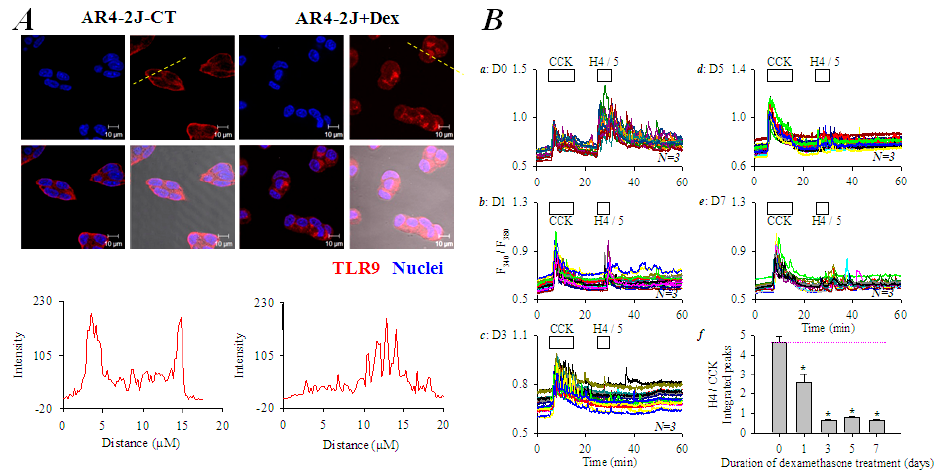
Figure 6. TLR9 migrates from the peripheral plasma membrane to cell interiors after Dex treatment, with concurrent disappearance of histone-induced calcium oscillations in AR4-2J cell clusters. ( A ) TLR9 migration from peripheral plasma membrane to cell interiors after Dex. AR4-2J cells were grown in normal medium (AR4-2J-CT) or in medium containing Dex 10 nM (AR4-2J + Dex) for 5 days before immunocytochemistry. Anti-TLR9 primary and TRITC-conjugated secondary antibodies were used (red). The nucleus was counter-stained with Hoechst 33342 (blue). Confocal images were taken (Zeiss 700) with λ ex : TRITC/555 nm, Hoechst 33342/405; λ em : 576 nm and 461 nm respectively. Both fluorescent and merged images are shown. The distribution of TLR9 protein content along the dashed thin yellow lines in the images was quantified by fluorescence line scans. Fluorescence intensity was concentrated on the plasma membrane and cell interiors in control (left) and Dex-treated (right) AR4-2J cells respectively. ( B ) Disappearance of histone-induced calcium oscillations after Dex. AR4-2J cells were treated with Dex 10 nM for 0, 1, 3, 5, 7 days ( a – e ) before detachment and measurements of H4 induction of calcium oscillations. Fura-2-loaded AR4-2J cells were perifused; CCK and H4 were added as indicated by the horizontal bars. In each experiment, CCK 20 pM was followed by H4 at 5 mgL − 1 in AR4-2J treated with Dex 10 nM for 0 ( a ), 1 ( b ), 3 ( c ), 5 ( d ) or 7 days ( e ). Ratios of integrated calcium responses H4 (25–55 min)/CCK (5–15 min) (area under peaks above the basal level) were plotted against days of Dex treatment ( f ). The dashed thin pink horizontal line in ( f ) indicates the ratio (H4/CCK) in control AR4-2J not treated with Dex. Asterisk (*) indicates P <